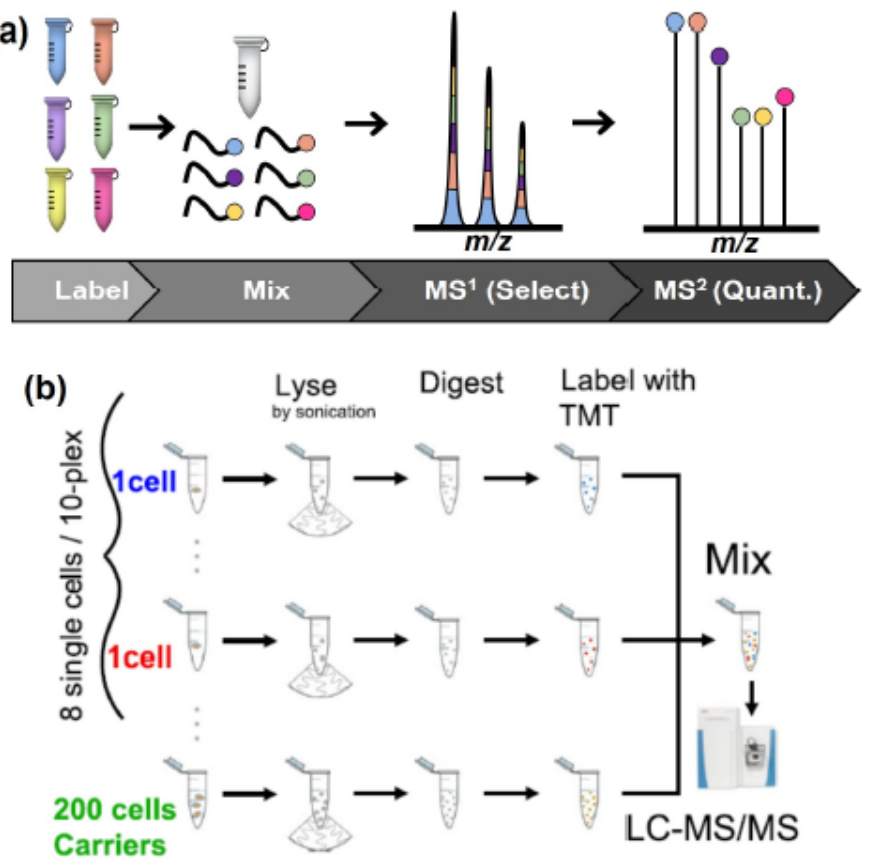
Figure 7. Multiplex analysis of mammalian cell for increased throughput and sensitivity. ( a ) Overview of the principle underlying multiplexed quantification with designer mass tags. ( b ) Single-cell proteomics by mass spectrometry (ScoPE-MS) enables the analysis of eight cells together. Reproduced from reference [119].